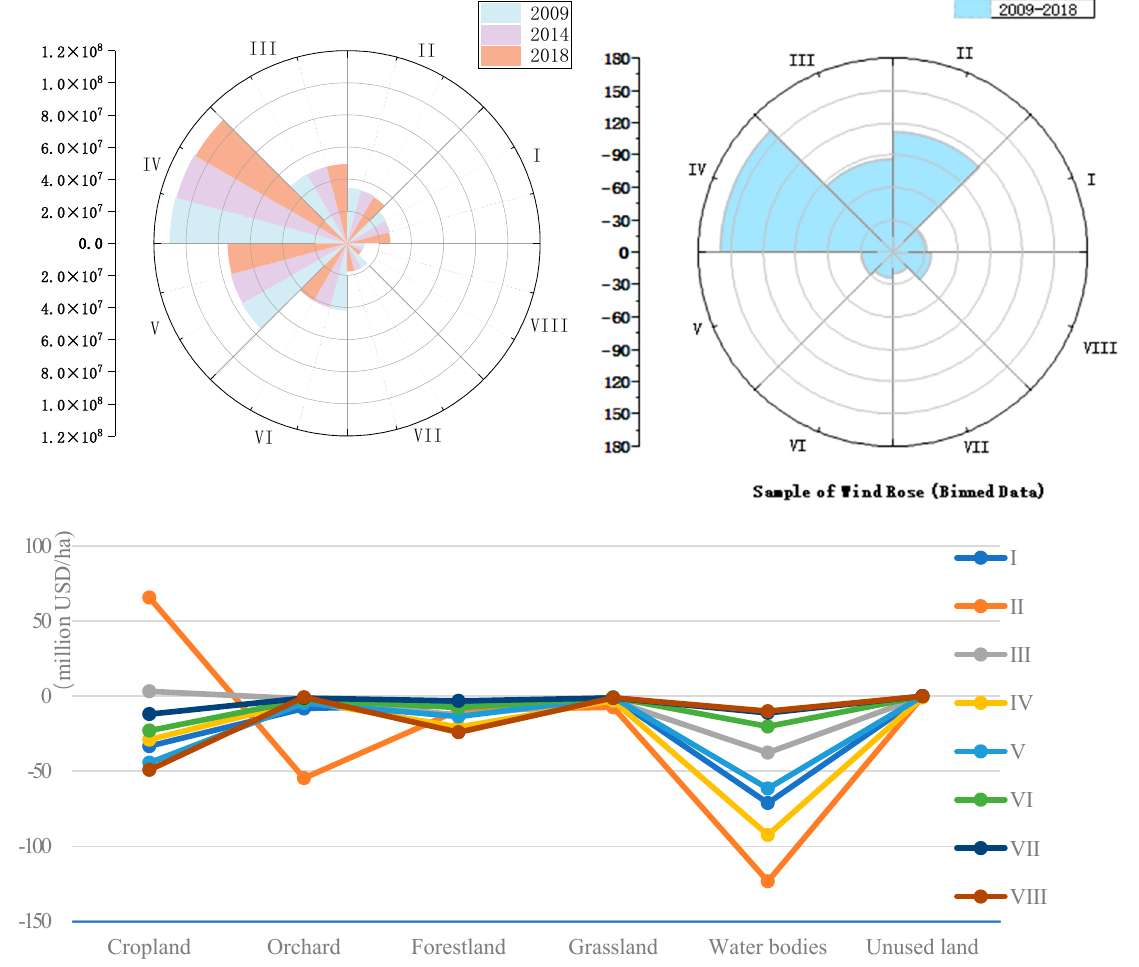
Figure 6. ESV and ESV change per unit area (USD ha − 1 ) in different directions from 2009 to 2018.